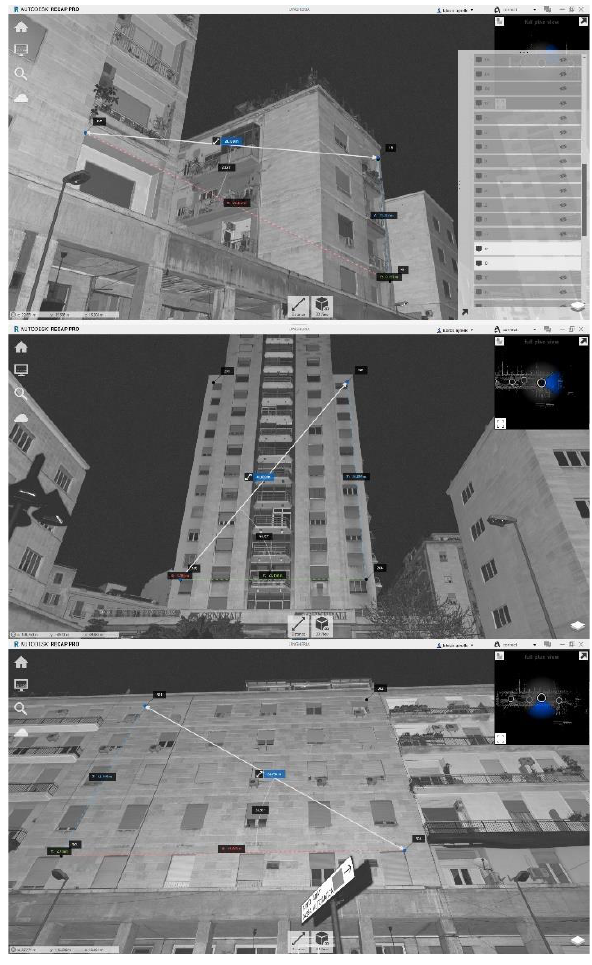
Figure 6: The rectangles used for the comparison with perspective restitution on the left front (above), on the high building (centre) and on the right front